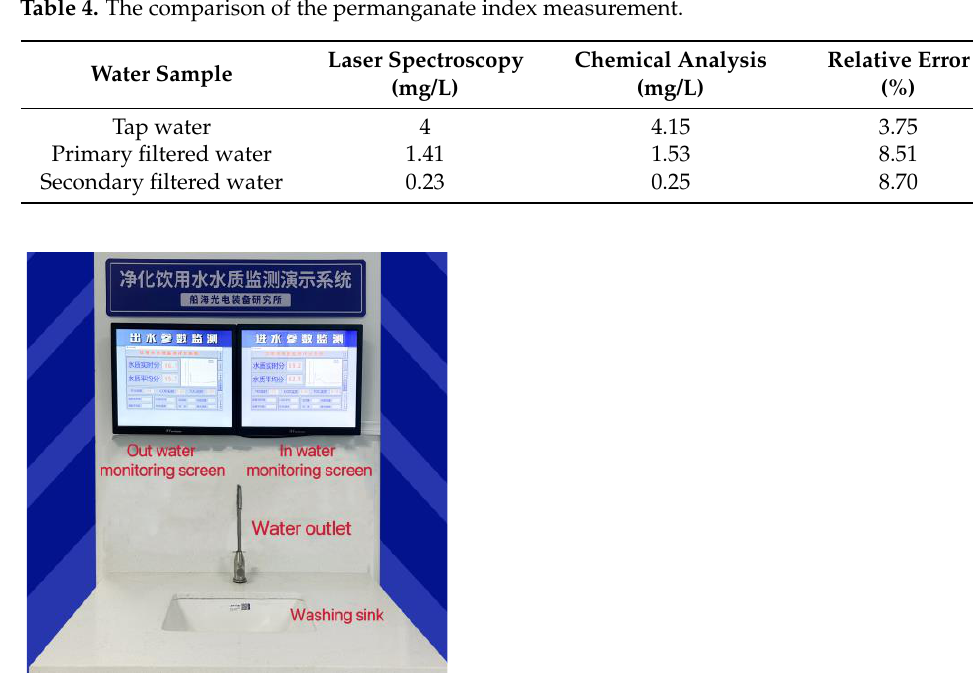
Figure 4. The drinking water quality monitoring demonstration